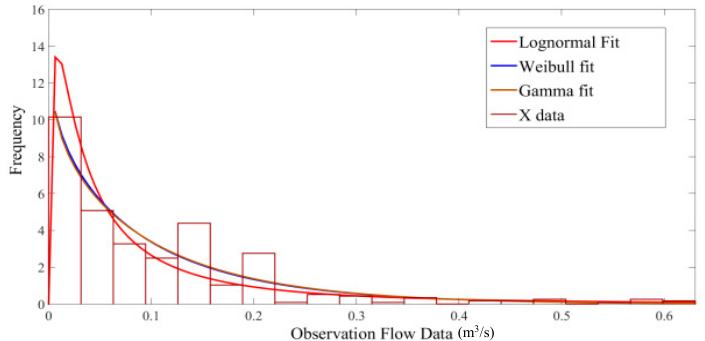
Figure 6. Comparison of fitted distributions with the observation flow data grouped into 20 classes. Table 3. Estimated parameters for selecting distributions.